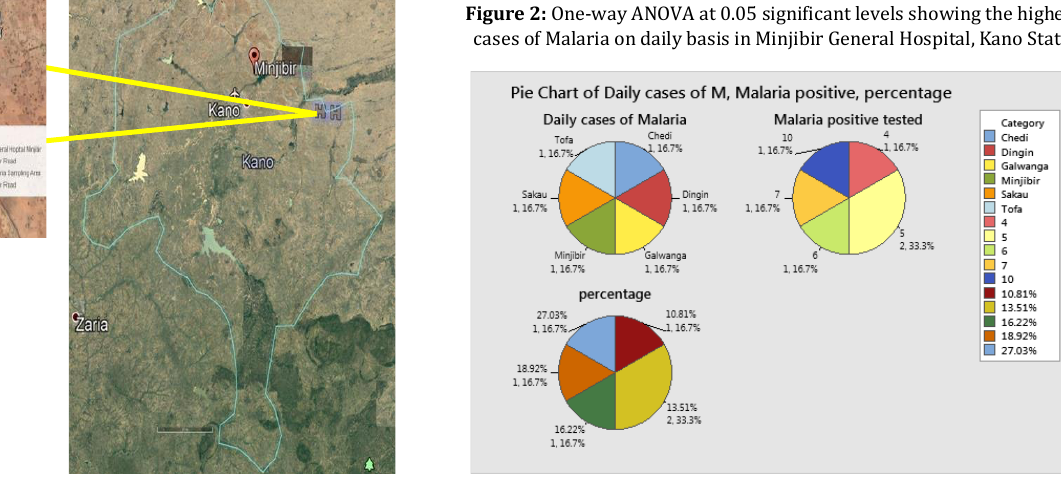
Figure 1: Map of the Malaria Affected area Minjibir, Kano State